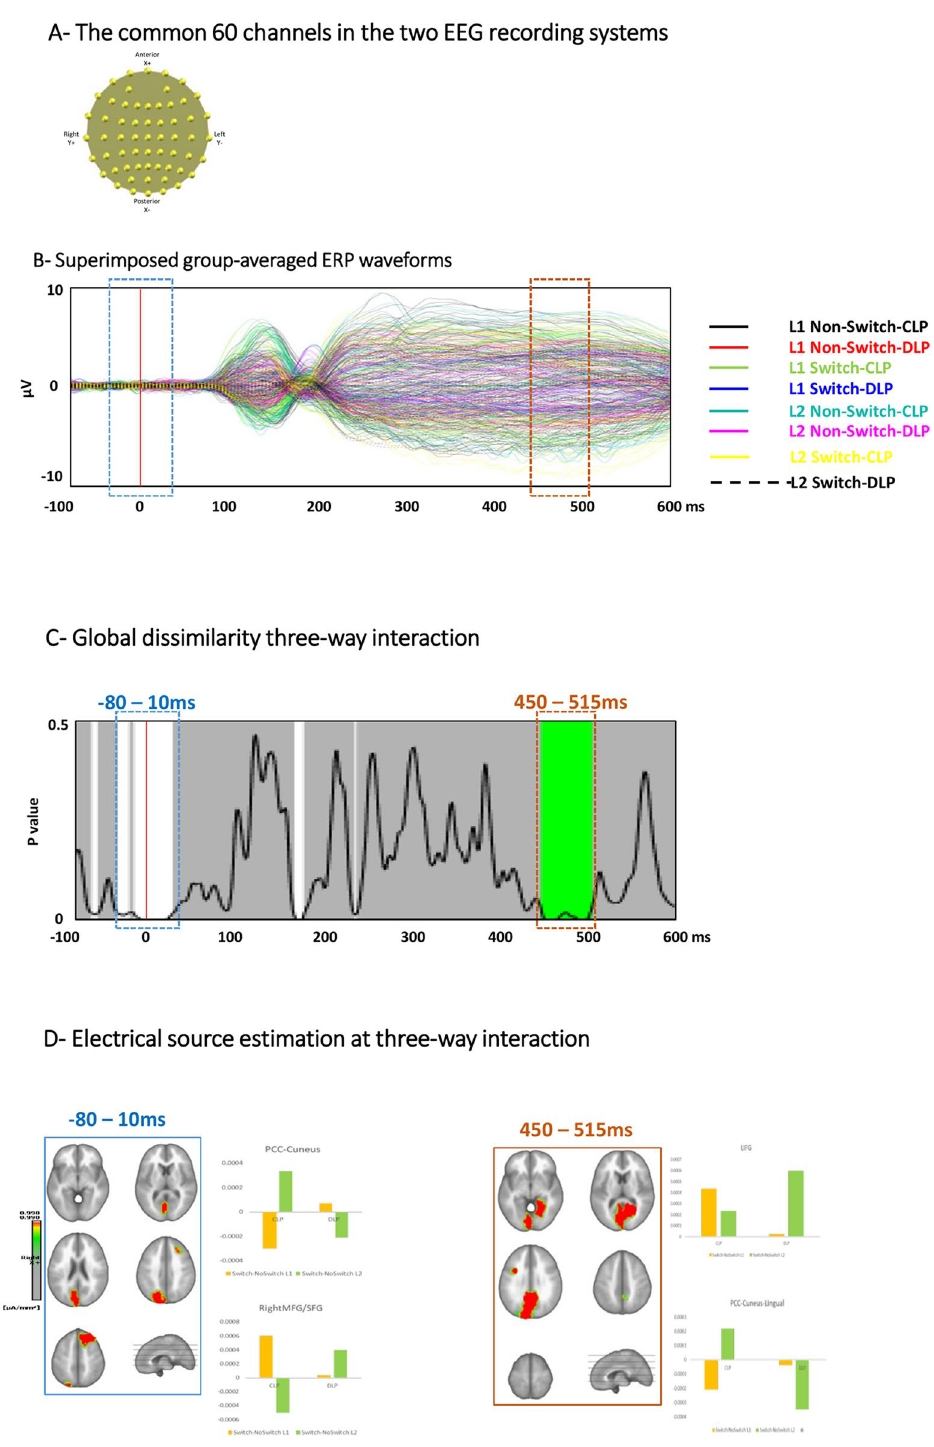
Figure 3. Electrical neuroimaging results: The picture-naming task; ( A ) The 60 common electrodes in the two EEG systems. Although both EEG recording systems consisted of 64 electrodes, only 60 of them had similar coordinates. These 60 channels were kept for the analyses. ( B ) Superimposed group-averaged ERP waveform of all conditions of interest. ( C ) Global dissimilarity analysis [Language (L1; L2) × Switch (Non-Switch; Switch) × Group (CLP; DLP)]. This analysis showed two time windows of significant interaction at − 80 to 10 ms peristimulus and 450 to 515 ms poststimulus presentation. ( D ) Electrical source estimation at the time windows of the significant three-way